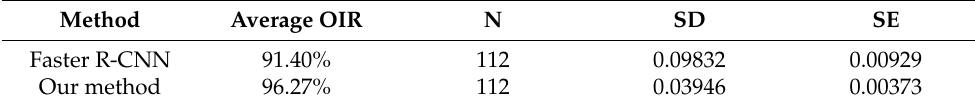
Table 3. A comparison of two methods on average OIR results and statistic metrics.